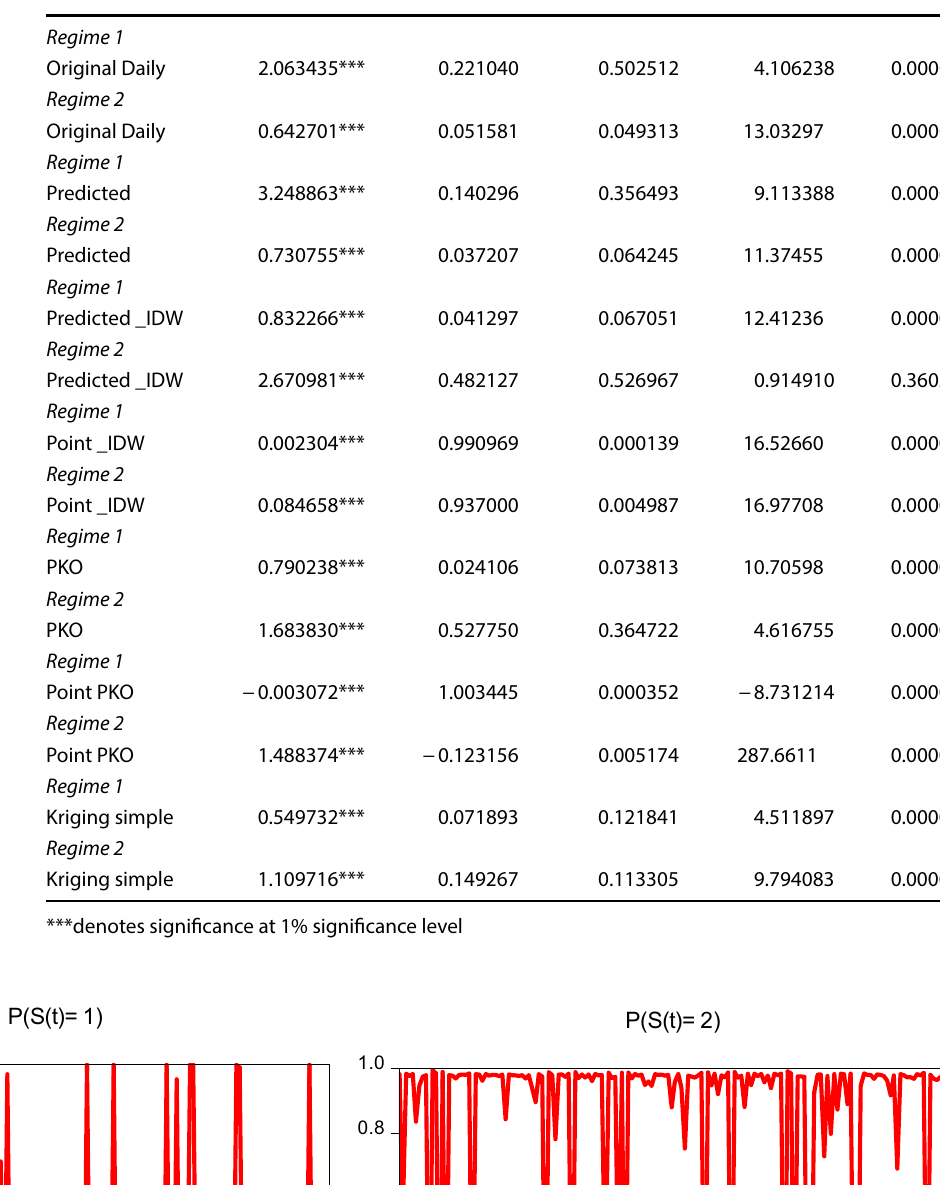
Table 1 Markov regimes switching results of daily rainfall